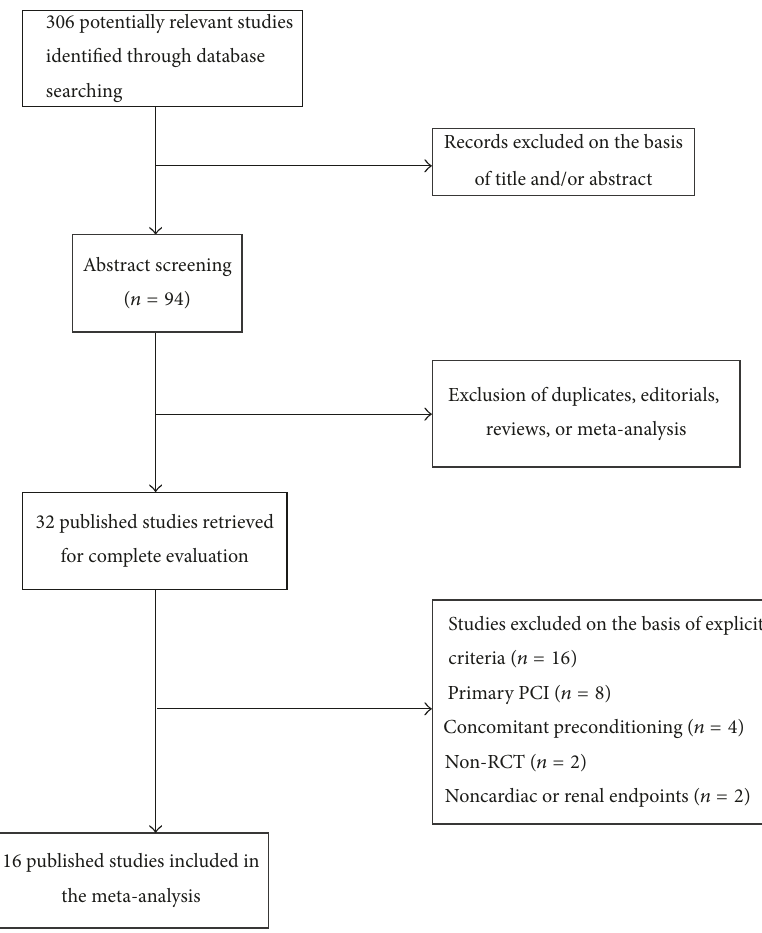
Figure 1: Flow chart of the studies identified with criteria for inclusion and